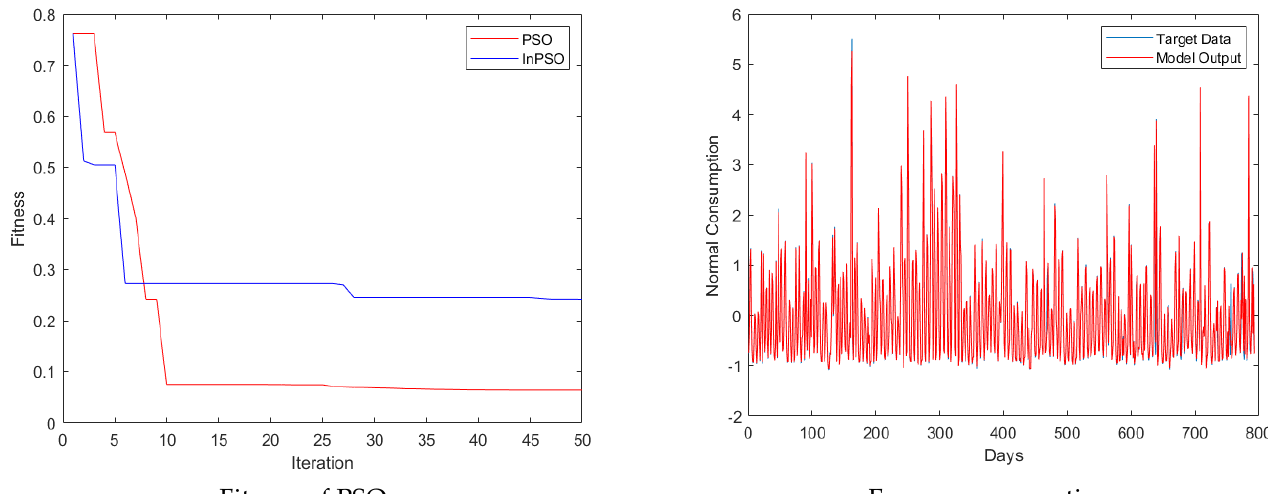
Figure 3. Predictions based on DNFW for energy consumption in Ahvaz.